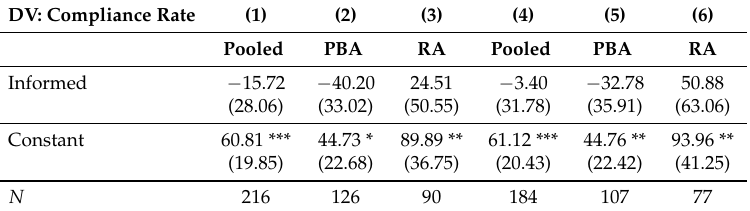
Table A2. Information treatment regressions